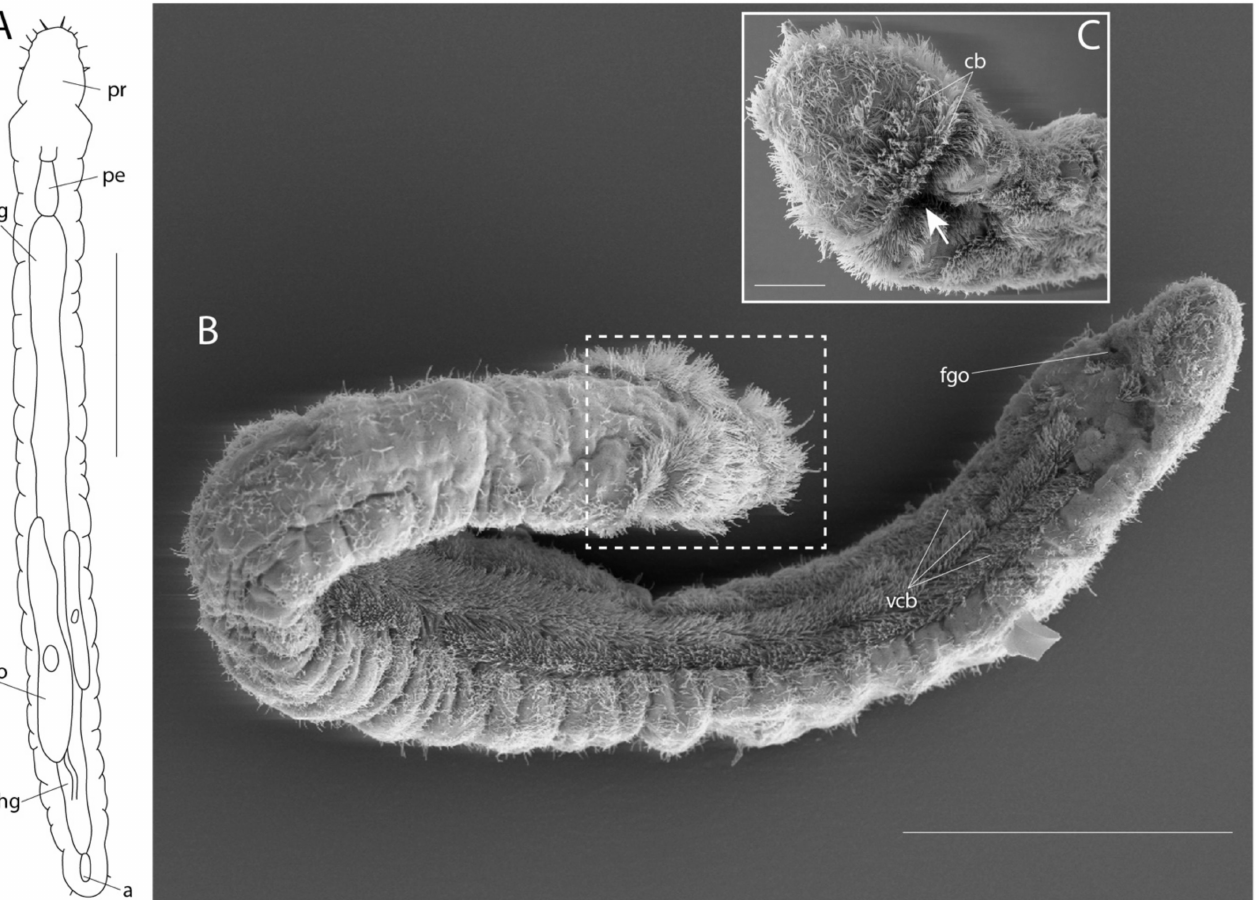
Figure 2. Apharyngtus punicus Westheide, 1971. ( A ) Dorsal overview of a mature female, redrawn from Westheide [72]. Scale = 200 µ m; ( B ) scanning electron micrograph of a mature female in semi-curled state, note the three ventral longitudinal bands of locomotory cilia. Prostomium enclosed by the dashed box. Scale = 100 µ m; ( C ) scanning electron micrograph of the ventral side of the prostomium. White arrow indicates mouth opening. Scale = 20 µ m. Micrographs courtesy of Günter Purschke. Abbreviations: a, anus; cb, ciliary bands; fgo, female genital opening; hg, hindgut; mg, midgut; oo, oocyte; pe, posterior esophagus; pr, prostomium; vcb, ventral ciliary